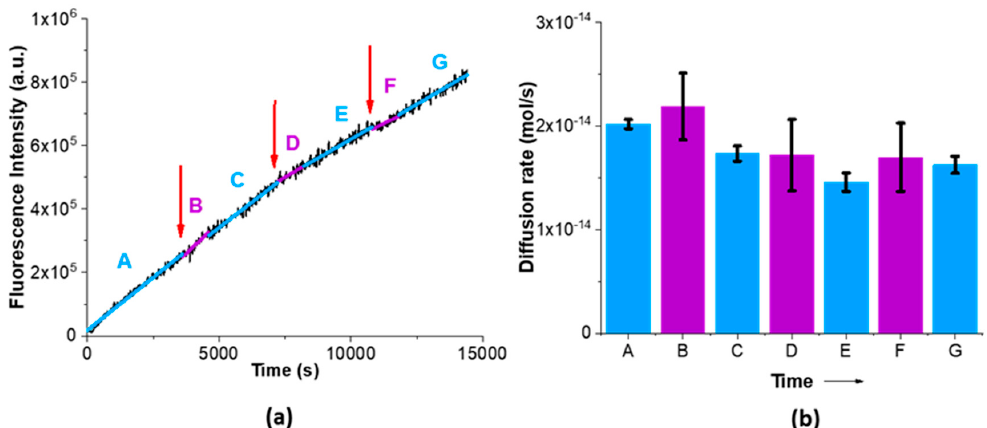
Figure 2. ( a ) Fluorescence intensity of sulforhodamine B (SRB) (solid black line) that diffuses across the dialysis membrane (measured in the bottom compartment of the cuvette, in PBS). The system is followed continuously for 4 h ( λ exc = 566 nm, λ em = 589 nm). The red arrows indicate acid additions in the top compartment of the cuvette, blue lines (zones A, C, E, and G), and purple lines (zones B, D, and F) indicate basic and acid pH periods in the top compartment, respectively. ( b ) Diffusion rates of free-SRB in solution at basic (blue) and acid (purple) pH — A to G indicate the time intervals shown in ( a ); average number of points for the calculation of each error bar, n = 100. Since the surface charge of silica changes with pH, it is important to evaluate this effect on the release of cargo from the MSNs pores. The isoelectric point of silica is at ca. pH = 2, so that the silanol groups are protonated (positively charged) at pH < 2, and deprotonated (negatively charged) at pH > 2 [24]. Using bare MSNs (no polymer shell) we were able to load 0.28 mmol of SRB per gram of MSN. This is similar to the loading obtained using the hybrid polymeric MSNs (above), meaning that in ethanol the polymer chains in the shell do not hinder the diffusion of SRB molecules into the mesopores in the hybrid nanoparticles. Release experiments were performed in the same conditions as for free-SRB, but using SRB-loaded bare MSNs in the top compartment of the cuvette (Figure 3).